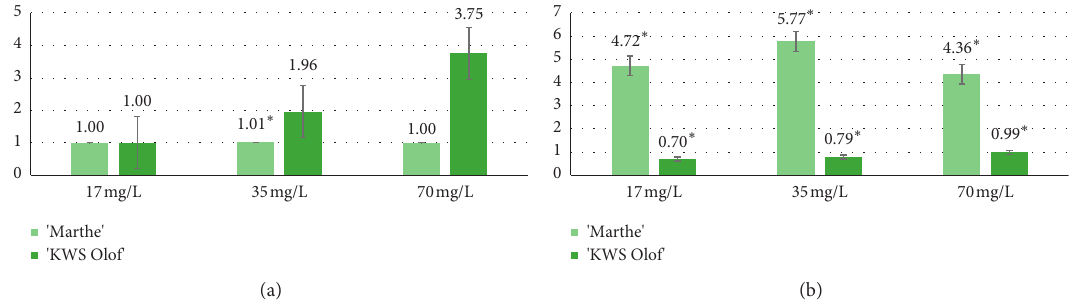
Figure 7: Comparison of 17 mg/L, 35mg/L, and 70mg/L concentrations of Fe 3 O 4 and CuO NPs effects on the miR156a expression level in “Marthe” and “KWS Olof” varieties. Values are the mean of three replicates with SD. ∗ Indicates a significant difference from control ( p < 0.05). (a) Comparison of the different concentration Fe 3 O 4 NP effect on miRNA expression in “Marthe” and “KWS Olof” varieties. (b) Comparison of the different concentration CuO NP effect on miRNA expression in “Marthe” and “KWS Olof”